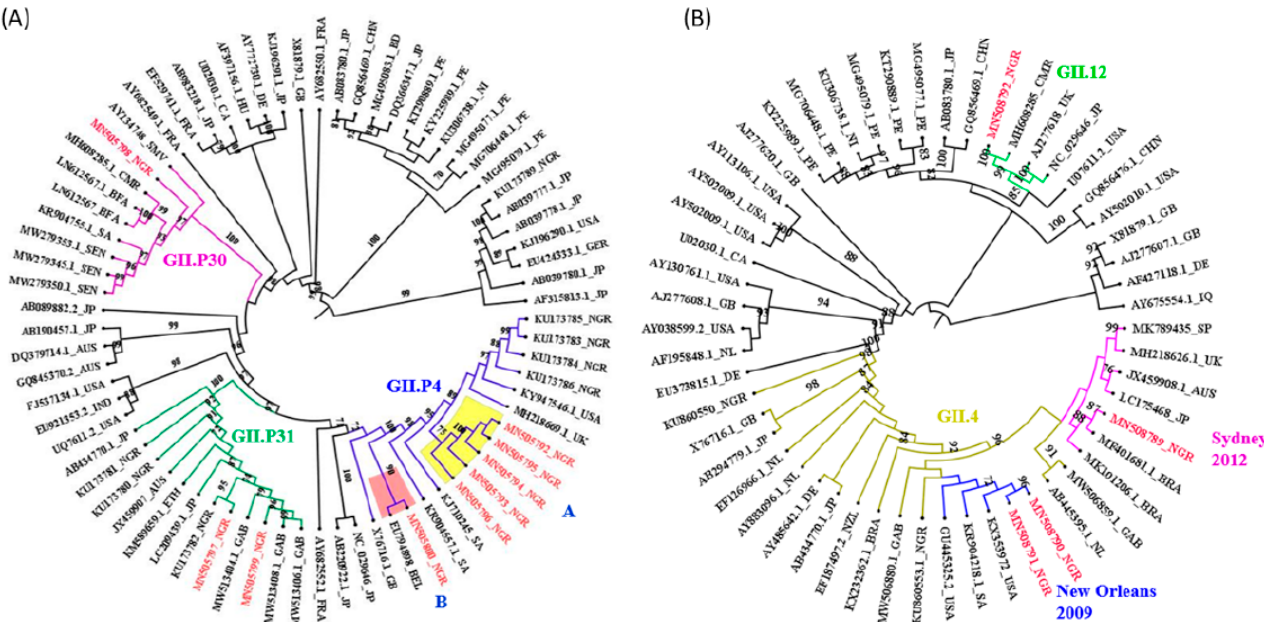
Figure 3. Maximum-likelihood phylogenetic trees of NoV strains identified in children with acute gastroenteritis in Ogun State, Nigeria, from February 2015 to April 2017. ( A ) Partial RdRp region A ( B ) Partial VP1 region D. Colored text indicates the study strains and reference strains obtained from the GenBank database are indicated by accession numbers (in black). Bootstrap support values > 70 (1000 replicates) are shown next to the branches.